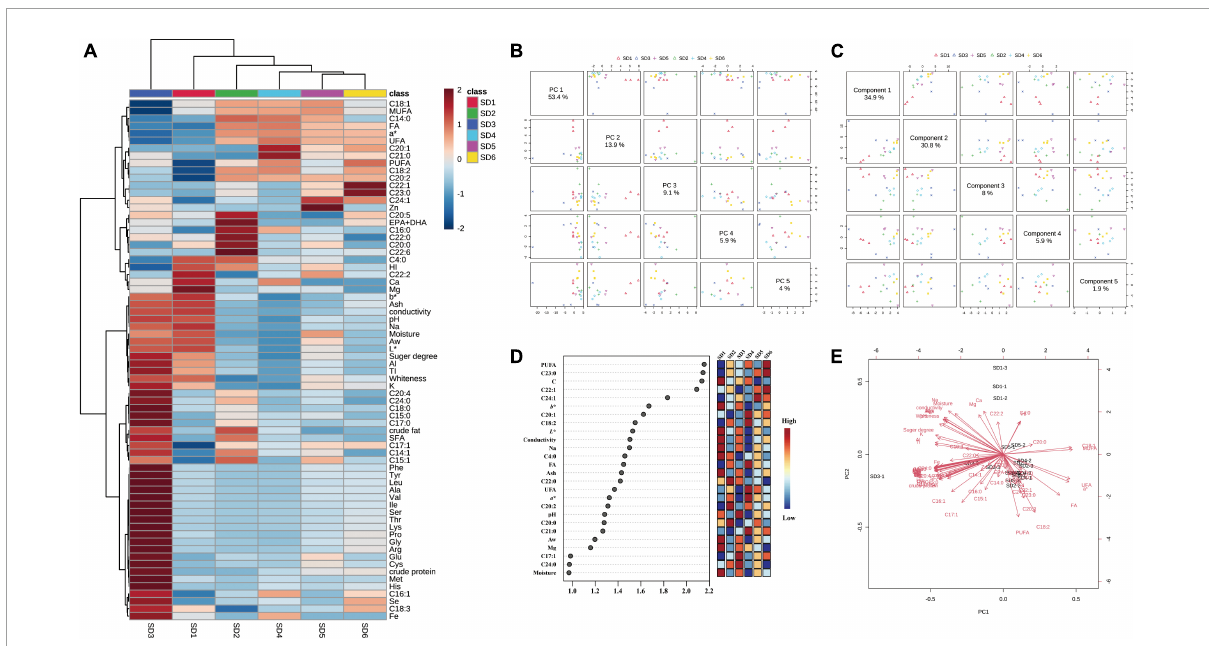
FIGURE1 Analyses of principal components and partial least squares. (A) Ingredients heat map, (B) principal component analysis plot, (C) partial least squares analysis plot, (D) VIP values, and (E) salad dressings and nutrient content biplot model analysis. Thr, threonine; Val, valine; Ile, isoleucine; Leu, leucine; Lys, lysine; Met, methionine; Cys, cysteine; Phe, phenylalanine; Tyr, tyrosine; EAAI, essential amino acid